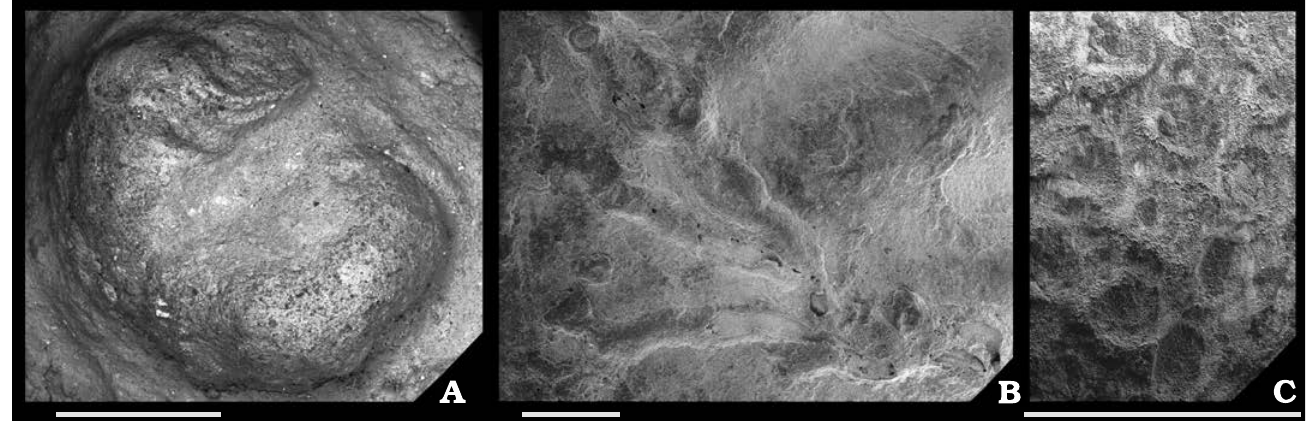
Fig. 4. Sclerobionts of the studied Roadian community from Monte Redondo loca lity, Chiapas, Mexico. A . Microconchus maya Heredia-Jiménez, Vinn and Torres-Martínez, 2020. B . Hederella carbonaria Condra and Elias, 1944. C . Encrusting bryozoans. Scale bars 1 mm.